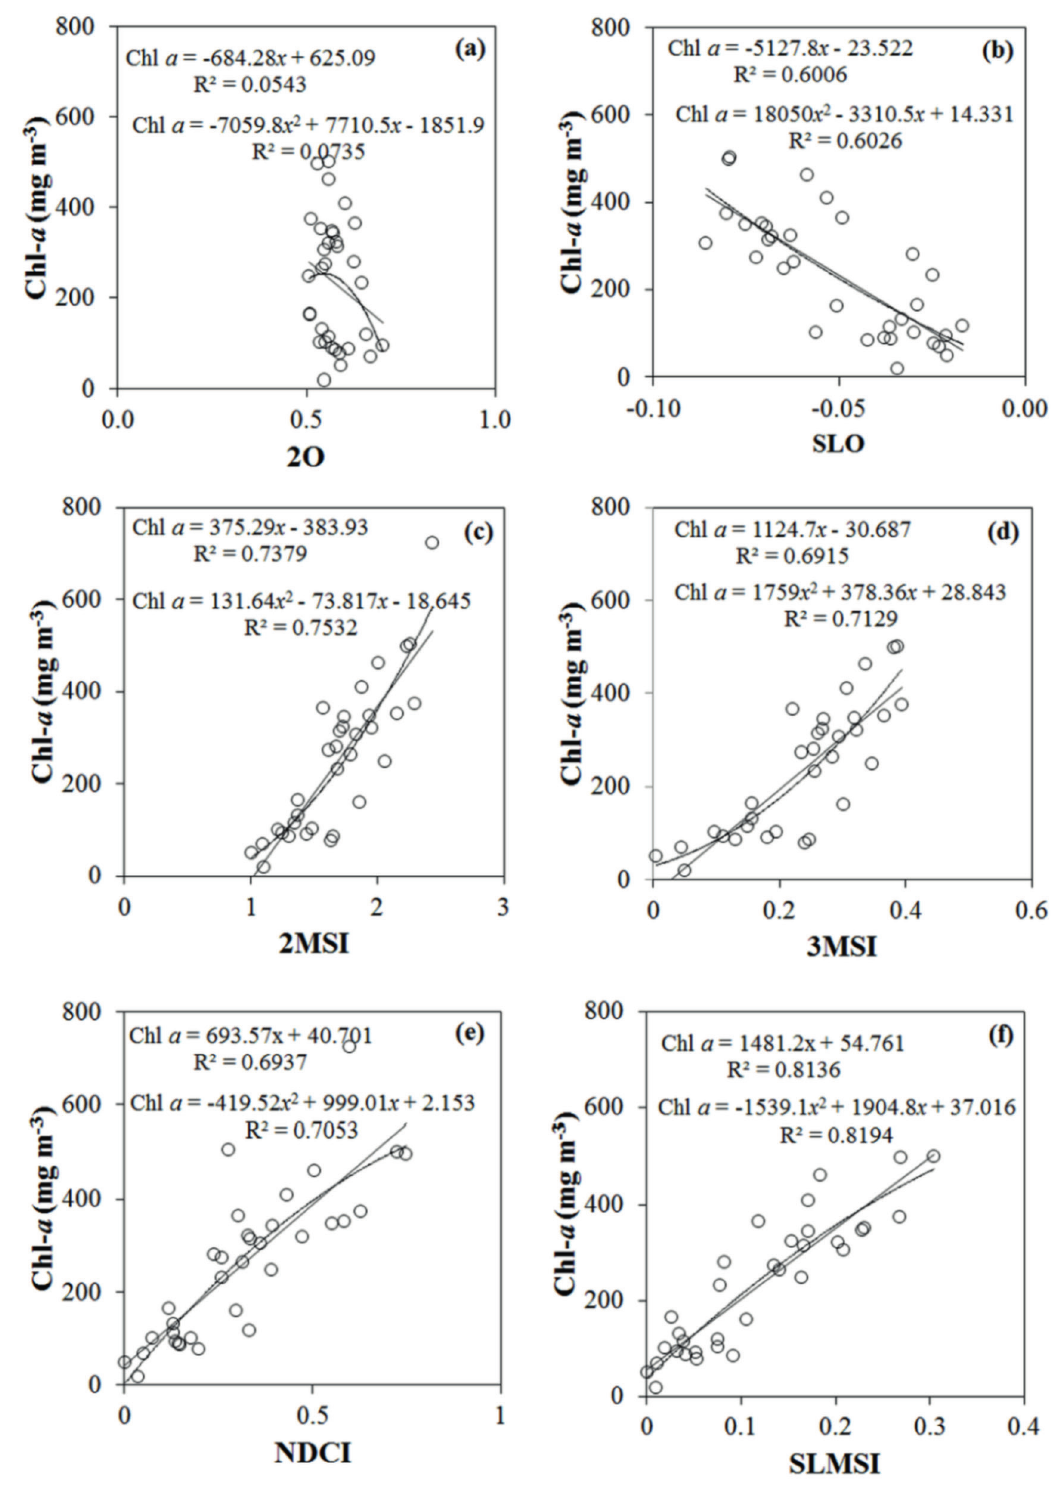
Figure 3 - Models of retrieving Chl- a using OLI/Landsat-8 bands and considering the spectral indexes ( a ) 2O and ( b ) SLO, and MSI/Sentinel-2A bands and indexes ( c ) 2MSI, ( d ) 3MSI, ( e ) NDCI and ( f )